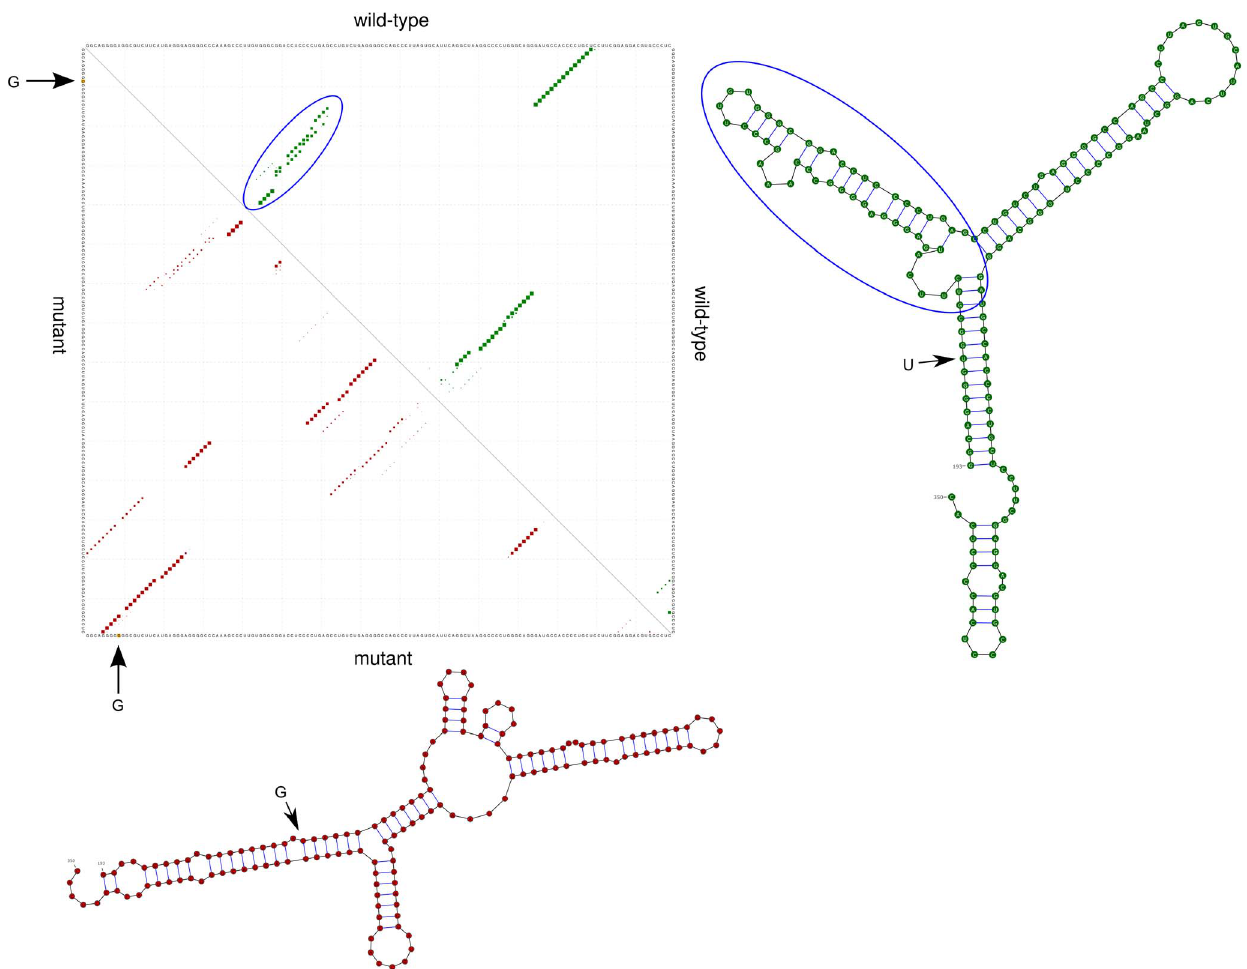
Figure 3. Results of SNV U1552G predicted to cause significant local secondary structure changes in 3 9 UTR of GPX3 mRNA. The dot plot from RNAsnp web server [67] shows the base pair probabilities corresponds to the local region predicted with significant difference ( d max p- value: 0.0474) between wild-type and mutant. The upper triangle represents the base pair probabilities for the wild-type (green) and the lower triangle for the mutant (red). On the sides, the minimum free energy (MFE) structure of the wild-type and mutants are displayed in planar graphic representation. The SECIS region is highlighted in blue circle and the SNV position is indicated with arrow mark.